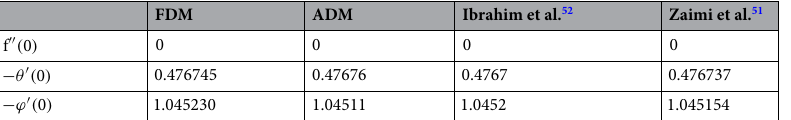
Table 1. Comparison of the values of f ′′ ( 0 ) , − θ ′ ( 0 ) and − ϕ ′ ( 0 ) with S = 0, (cid:31) = 1 in the boundary conditions (20) and taking Pr = 1, Le = 2, Nt = Nb = 0.5, c 2 = c 4 = c 6 = c 8 = 0 and m = 1 in the models of Ibrahim et al . 52 and Zaimi et al . 51